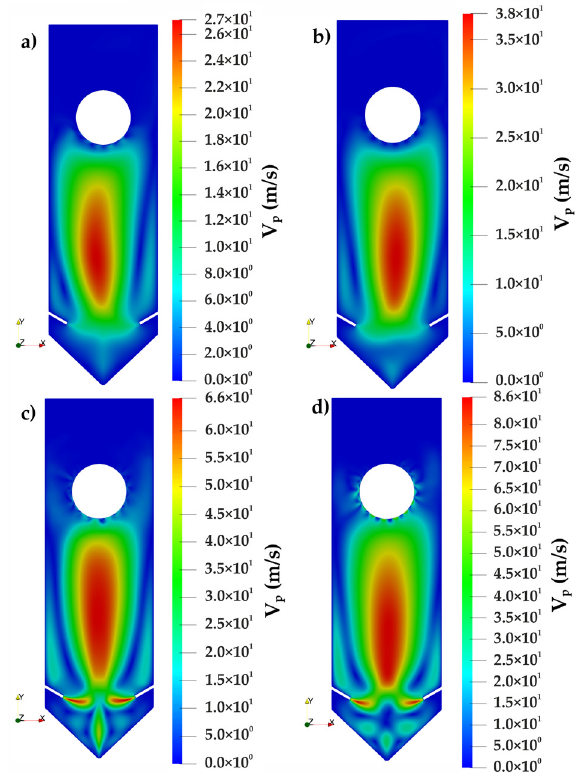
Figure 11. Time-averaged particle velocity distribution (resultant velocity) as a function of the solid holdup and the nozzle inlet pressure: ( a ) 400 g and 0.5 bar; ( b ) 400 g and 1 bar; ( c ) 700 g and 0.5 bar; ( d ) 700 g and 1 bar.